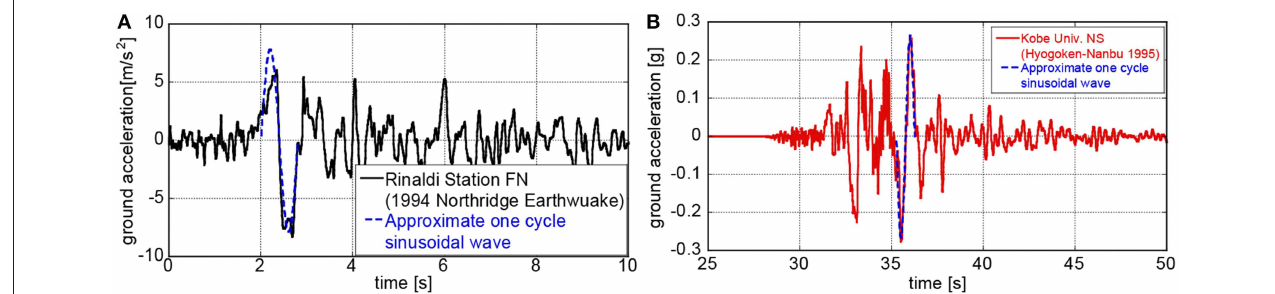
FIGURE 14 | Elastic-plastic response under Rinaldi station FN component of system with h ( V / V y 1.080), (A) Maximum deformation with respect to normalized input level, (B) Restoring force-deformation relation, (C) Normalized deformation time history, = (D) Normalized restoring-force time